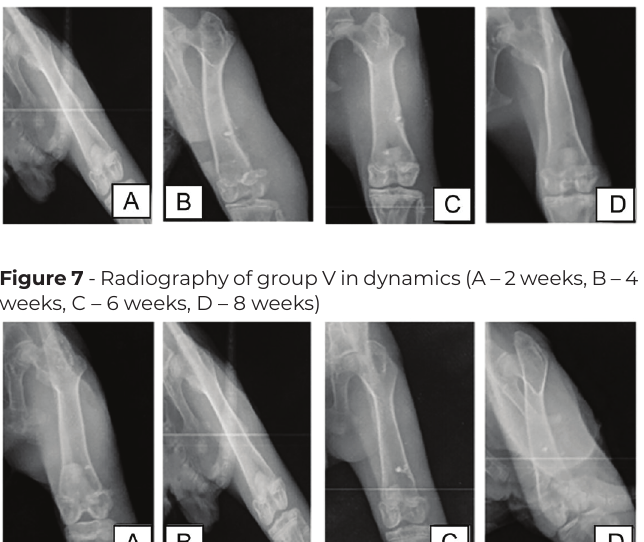
Figure 8 - Histological examination of chronic osteomyelitis (A – group I, B – group II, C – group III, D – group IV, E – group